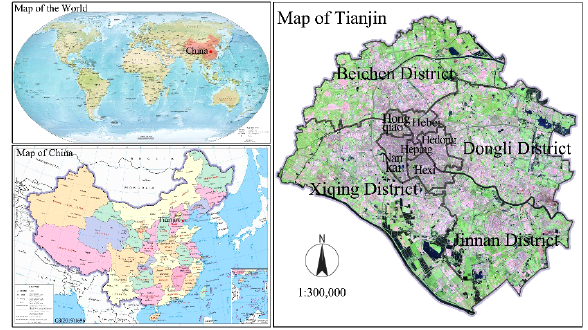
Figure 1. Overview of study